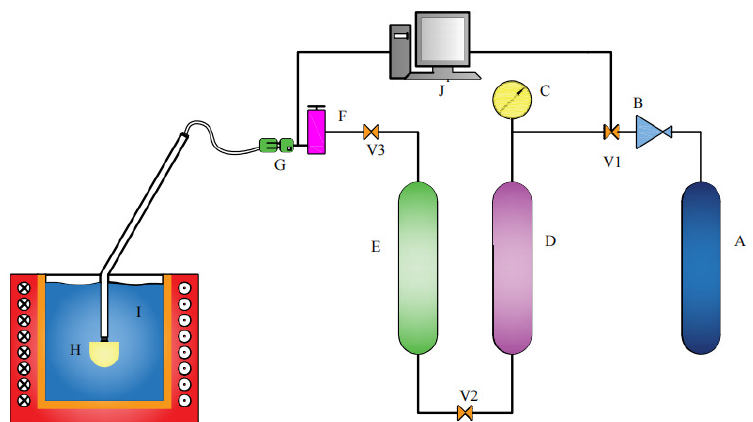
Figure 2. Assembly sketch of the equipment for hydraulic analogy. A—Nitrogen-gas tank; B—relief valve; C—manometer; D—air filter; E—molecular sieve; F—gas flowmeter; G—solenoid valve; H—porous nozzle; I—water; J—control panel; V1-V2-V3—common valve.